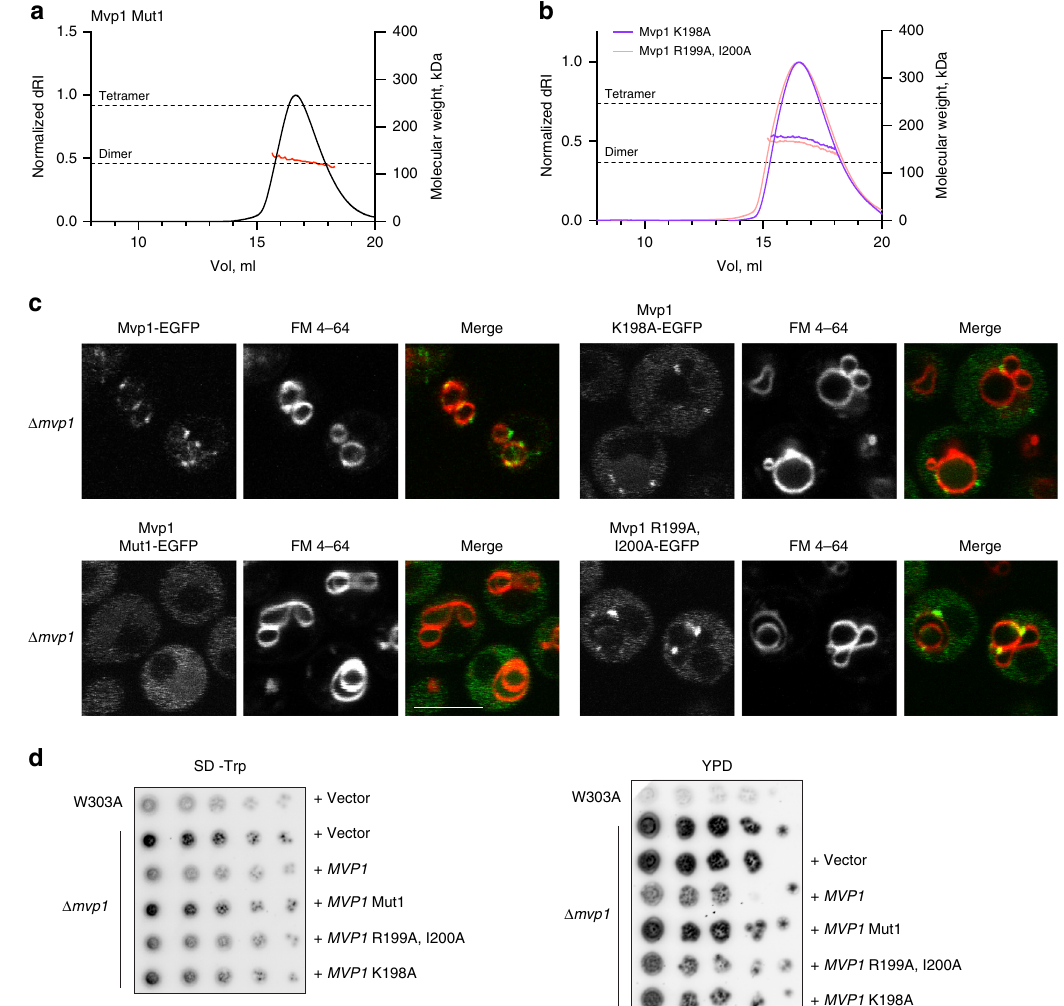
Fig. 3 Mvp1 Mut1 is dimeric and is defective in lipid binding and CPY sorting in vivo. The absolute molecular weights of Mvp1 Mut1 ( a ) or Mvp1 K198A (purple) or Mvp1 R199A, I200A (pink) ( b ) were determined using SEC-MALS as in Fig. 1. Proteins were eluted in buffer containing 250 mM NaCl. c Subcellular localization of EGFP-tagged Mvp1 and its mutants in Δ mvp1 cells. Vacuoles were stained with the lipophilic dye FM 4 – 64. Images were obtained by confocal microscopy. Scale bar — 5 μ m. d CPY secretion assays. W303A or Δ mvp1 cells expressing vector or the indicated construct were plated onto SD-Trp to maintain plasmid selection (left) or YPD (right) plates and incubated at 30 °C for 24 h. Plates were then overlaid with nitrocellulose for an additional 16 h. CPY secretion was detected by immunoblotting using an anti-CPY antibody. The leftmost spot in each case is 2 μ l of a OD 600 = 0.5 culture: spots to the right of this are sequential fi vefold dilutions. For d source data are provided as a Source Data fi